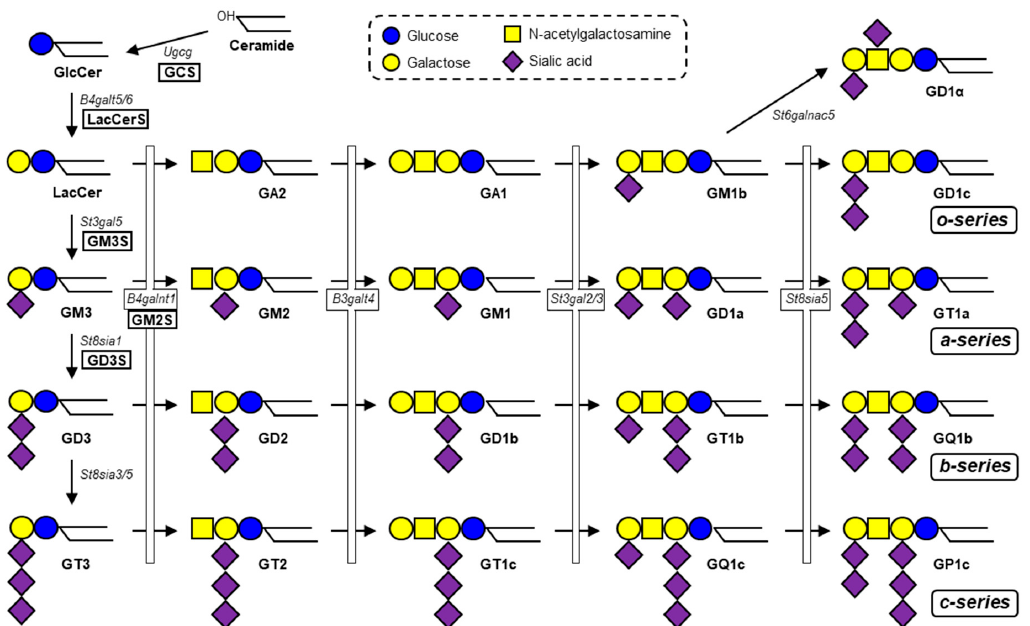
Figure 1. Biosynthetic pathway of ganglio-series gangliosides. GCS ( Ugcg ), a glucosyltransferase, catalyzes the first step in synthesis of ganglio-series gangliosides. Subsequently, LacCerS ( B4galt5/6 ) adds a galactose residue onto GlcCer to form LacCer. GM3S ( St3gal5 ) is a sialyltransferase required for initiation of synthesis of a- and b-series gangliosides. GD3S ( St8sia1 ) is a sialyltransferase required for synthesis of b-series gangliosides. Four species (GM1, GD1a, GD1b, GT1b) comprise the majority of total brain gangliosides in mammals.